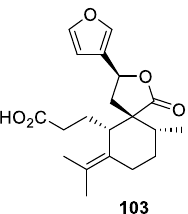
Figure 45. Secochiliolide acid.